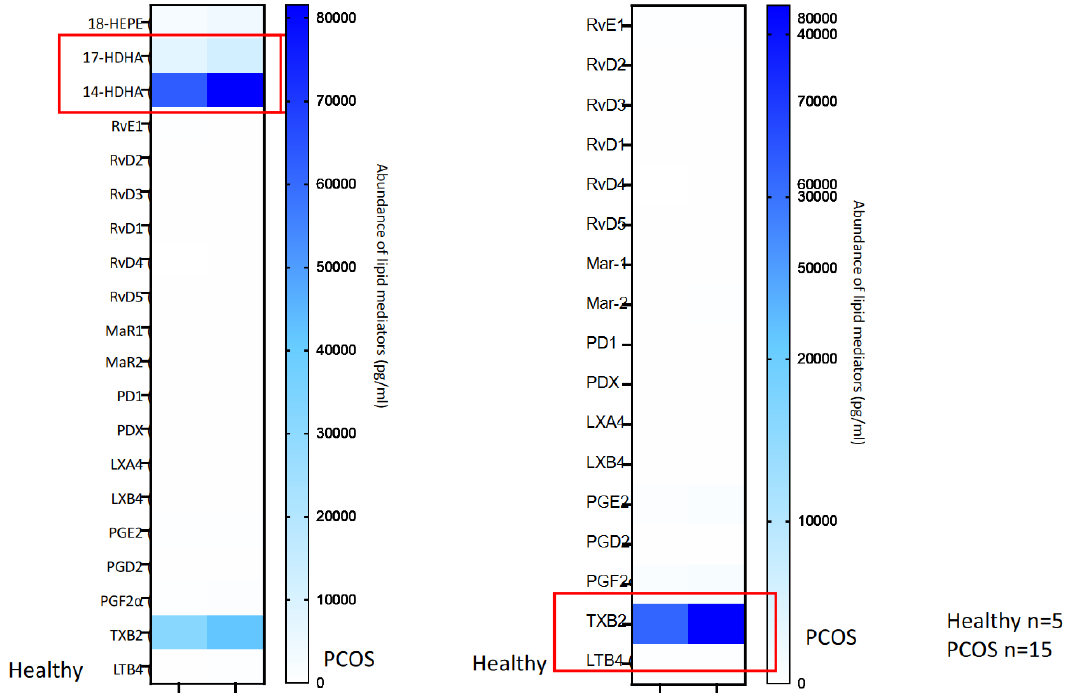
Figure 5. Heat map results in pg/mL of the human serum analyses of the healthy and PCOs patients.